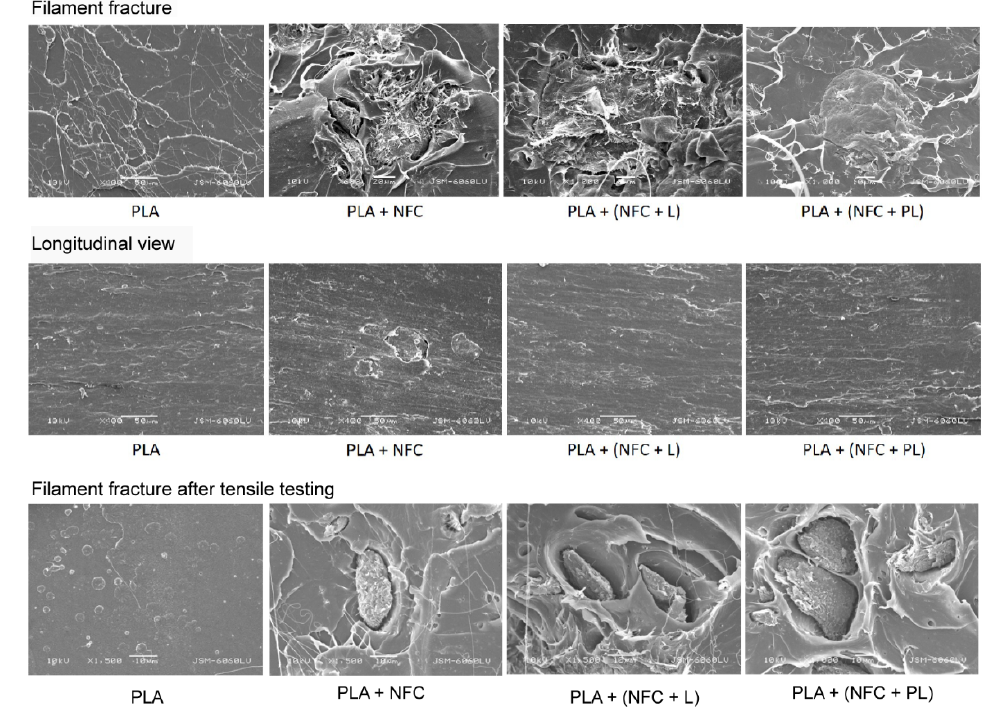
Figure 3. Filament fracture and longitudinal views of PLA and composite filaments PLA + NFC 3%, PLA + (NFC + L) 3%, and PLA + (NFC + PL) 3%; and fracture after tensile testing of PLA, PLA + NFC 5%, PLA + (NFC + L) 5%, and PLA + (NFC + PL) 5%.